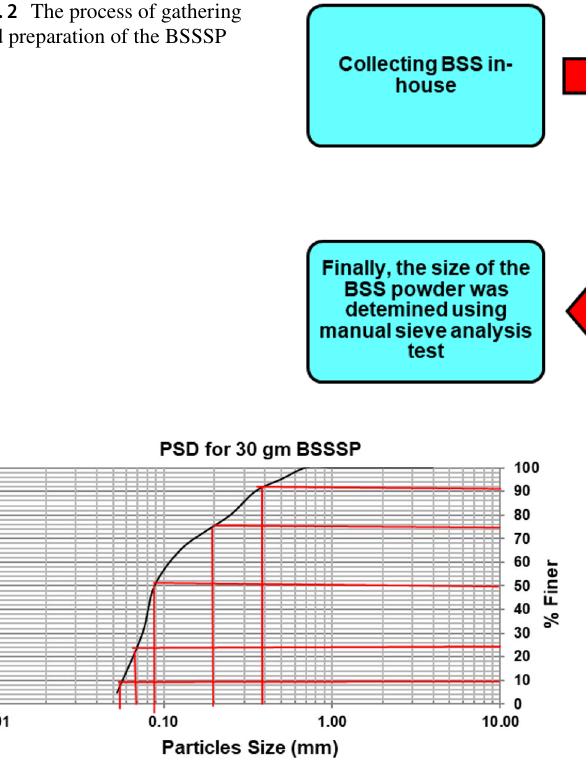
Fig. 3 The particle size distribution of the